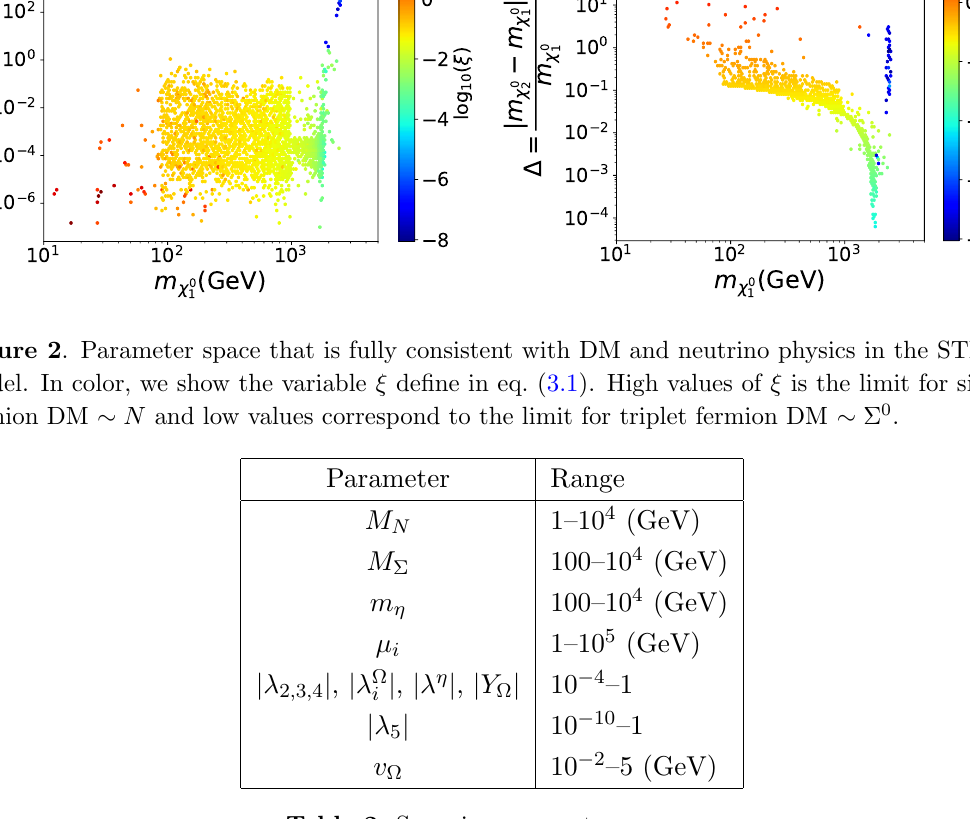
Table 2 . Scanning parameter